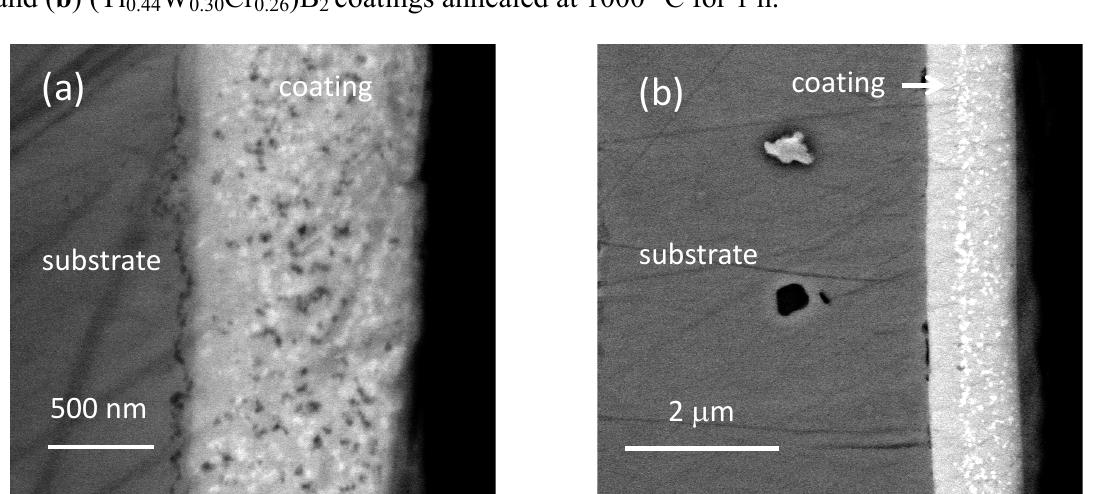
Figure 5. FESEM backscattering image in cross-sectional geometry for (a) (Ti